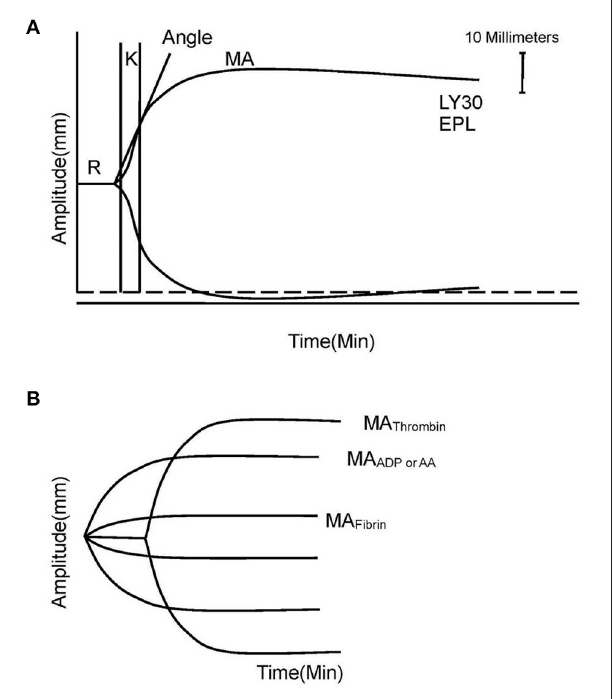
FIGURE 1 | Explanation of TEG and TEG-PM. (A) TEG parameters: K , angle, MA, EPL, and LY30. (B) TEG-PM parameters: MA Thrombin , MA ADP / AA , and MA Fibrin . TEG, thromboelastography; TEG-PM, thromboelastography with platelet mapping; R , time from the start of the test to clot formation; K , kinetics of the rate of clot formation; angle, velocity of clot strength generation; MA, maximum amplitude; EPL, percent of clot dissolution 30min after MA; LY30, percent of amplitude reduction at 30min after MA; AA, arachidonic acid; ADP, adenosine